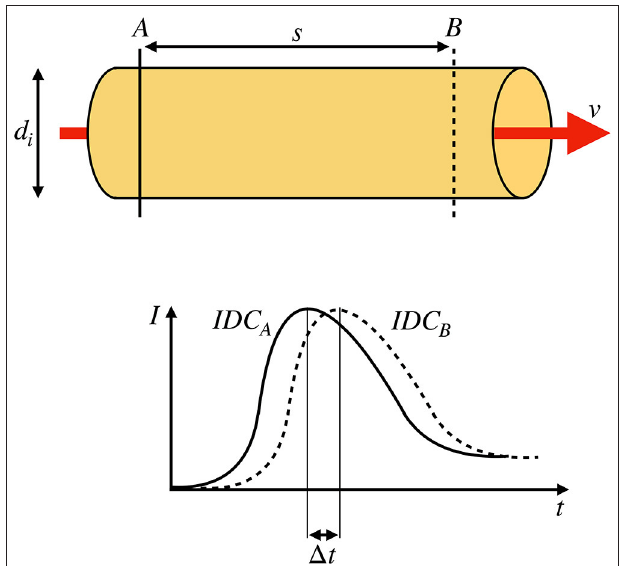
FIGURE 1 | (Top) Sketch of a rigid pipe with an inner diameter of d i containing a fluid flow with a constant mean flow velocity v . Two measurement points A and B with a distance of s are defined. (Bottom) Two indicator dilution curves (IDCs) obtained at the locations A and B by optical measurement. The transit time 1 t is defined as the shift of the curves as indicated by the shift of the